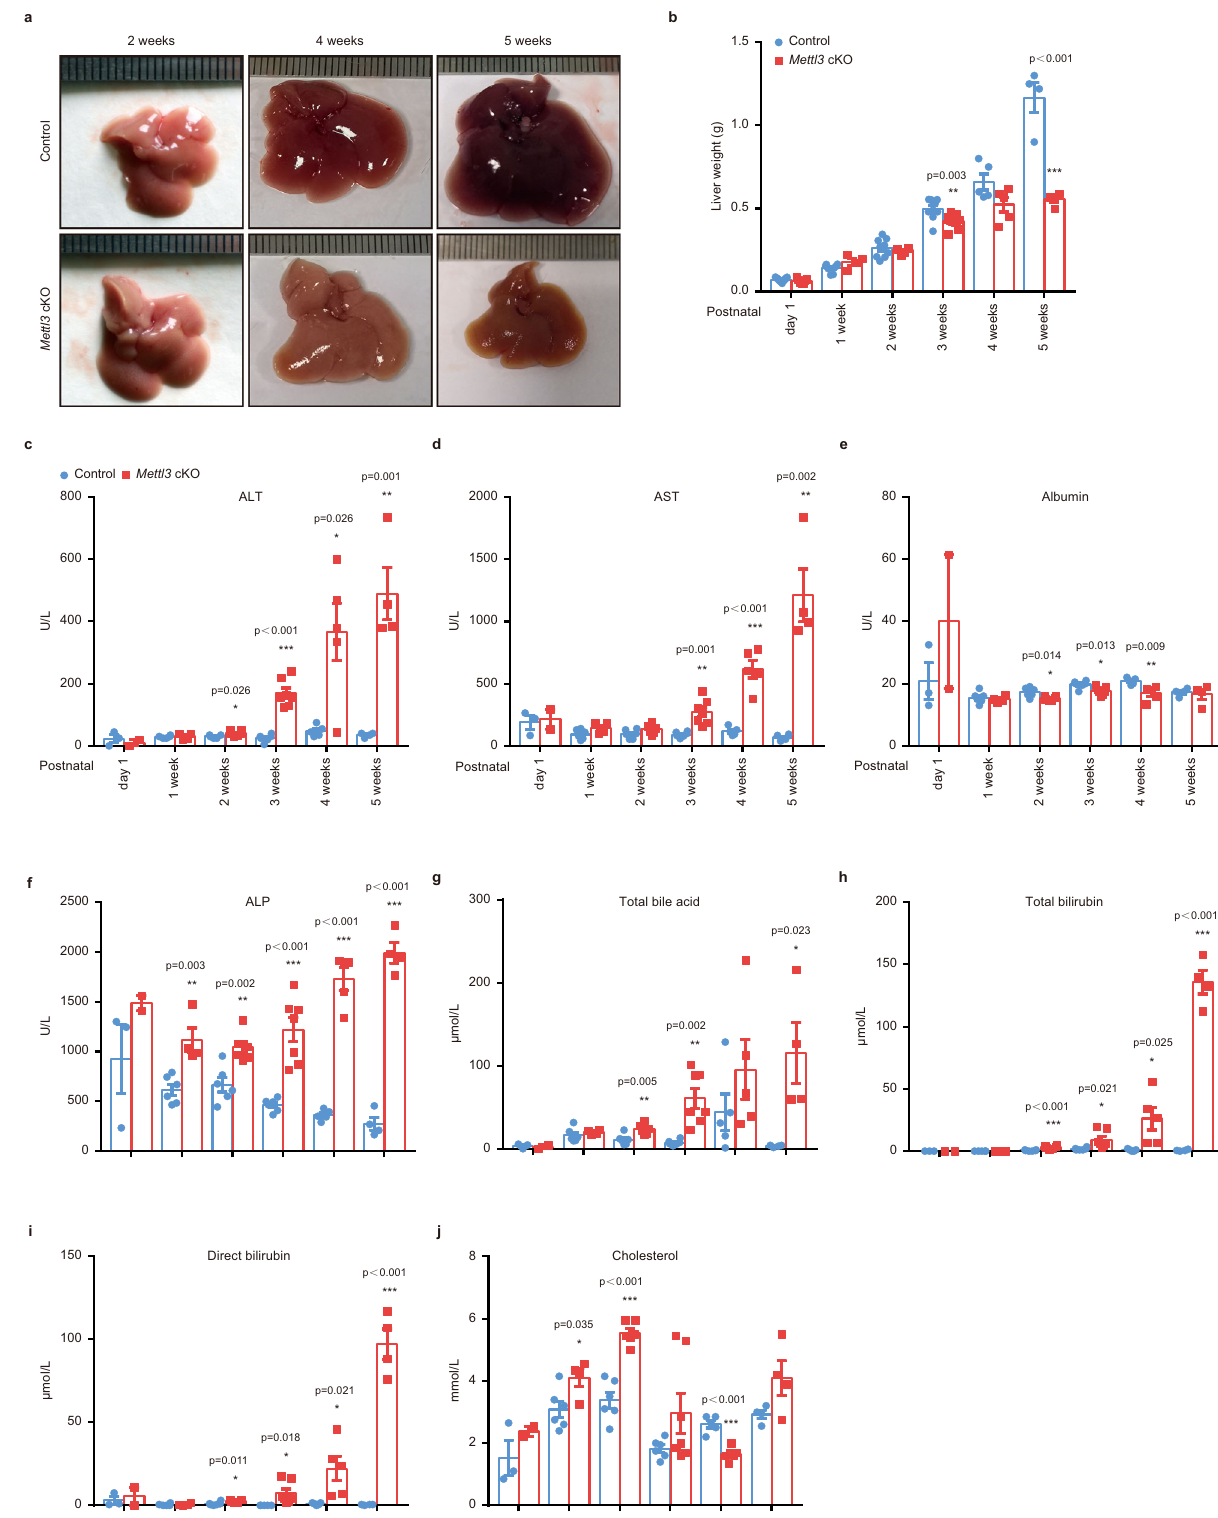
Fig. 2 | Hepatic Mettl3 knockout in mice causes liver injury. a Representative gross appearance of livers from Control and Mettl3 cKO mice at 2 weeks, 4 weeks, and5weekspostnatally. b Liverweightatdifferenttimepointspostnatally( n =4for 1 week cKO group and 5 weeks groups; n =5 for 4 weeks groups; n =6 for 2 weeks cKO group; n =7 for day 1 cKO group; n =8 for 1 week Control group; n =9 for 3 weeks Control group; n =10 for 2 weeks Control group; n =12 for 3 weeks cKO group; n =15 for day 1 Control group). c – j Serum levels of ALT c , AST d , Albumin